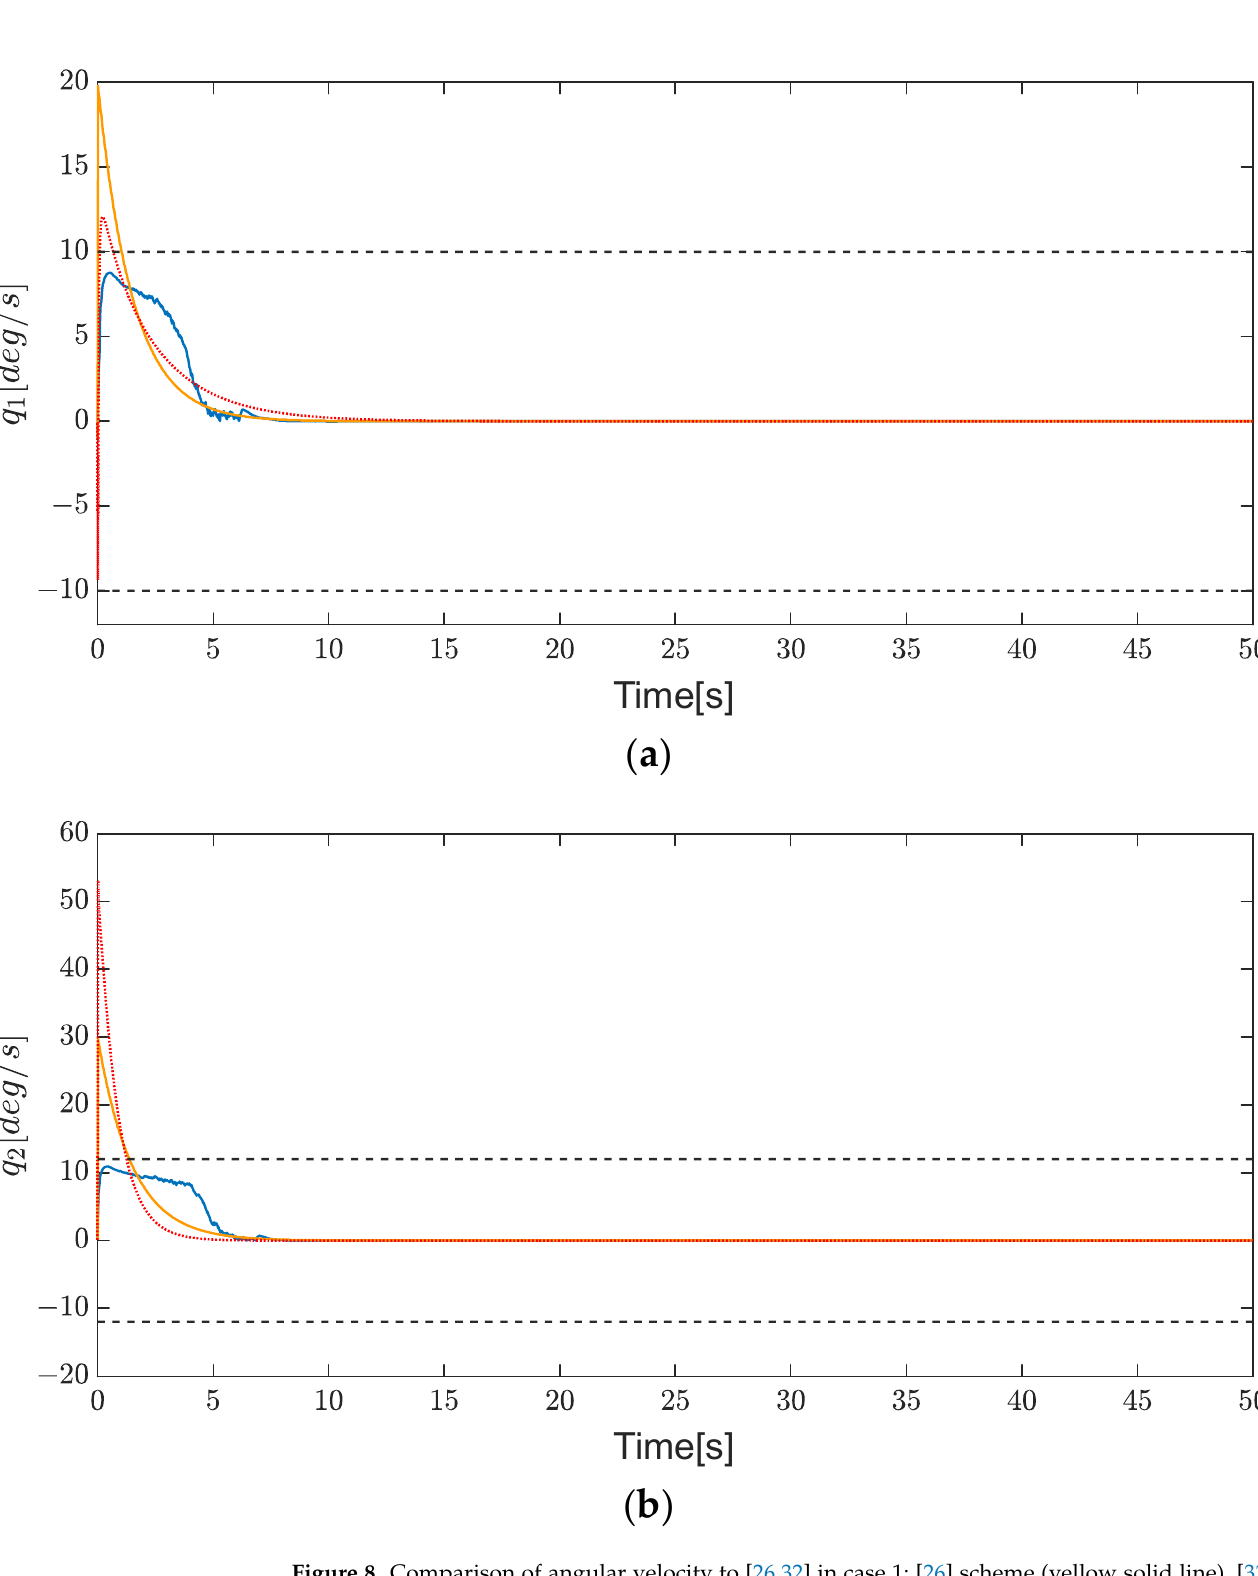
Figure 7. Comparison of the angular position to [43,44] in case 1: [43] scheme (yellow solid line), [44] scheme (red dash line), the proposed scheme (blue solid line), the reference angular position (green dashed line), the angular position constrains (black dashed line); ( a ) Joint 1. ( b ) Joint 2.